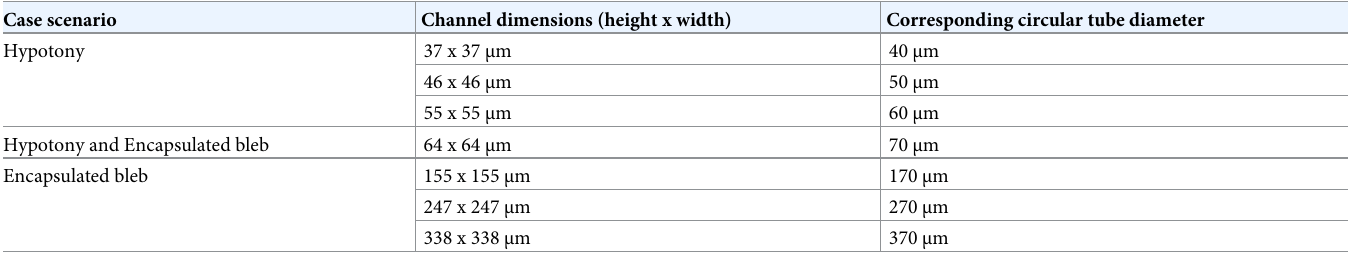
Table 3. Dimension of the channels of the microfluidic chips and corresponding tube